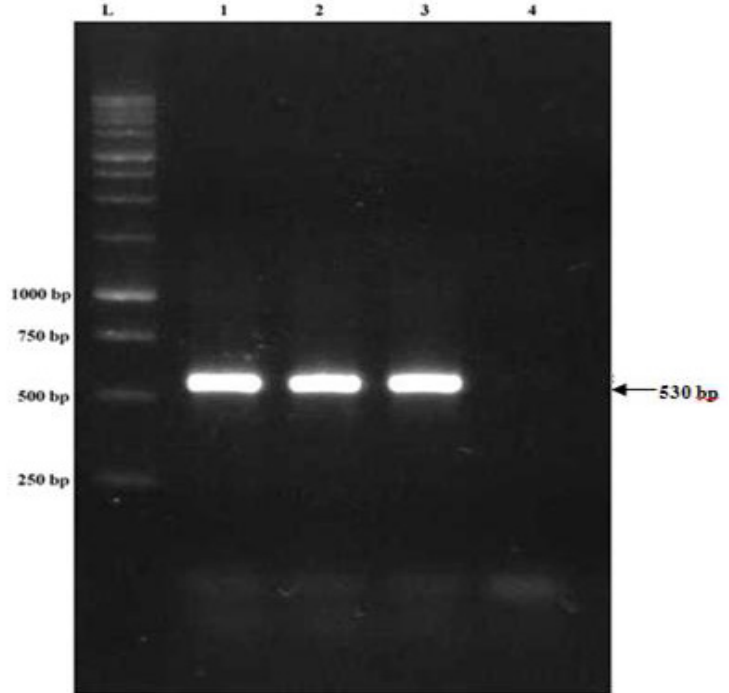
Figure 3: Electrophoresis in agarose gel of PCR amplification products with ITS1 and ITS4 primers for Corynespora cassiicola. Lanes L: DNA ladder, 1: Isolate TSI, 2: Isolate TS2, 3: Isolate TS3, 4: negative control